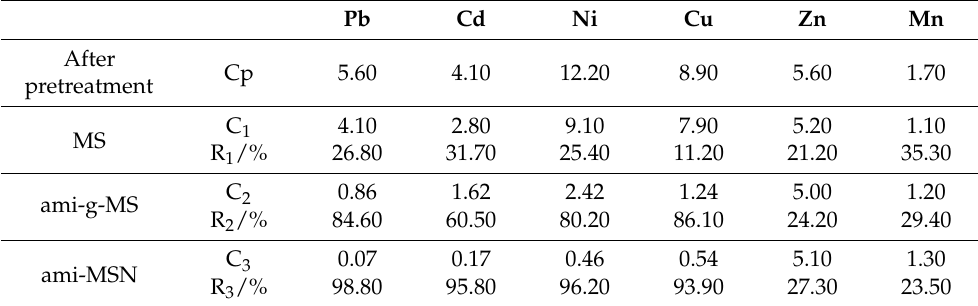
Table 2. Concentration of toxic metals (mg/L) before and after treatment.